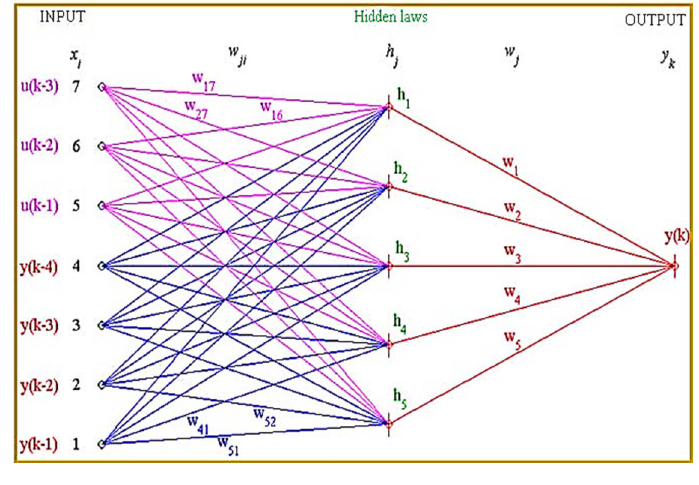
Figure 1. Perceptron.